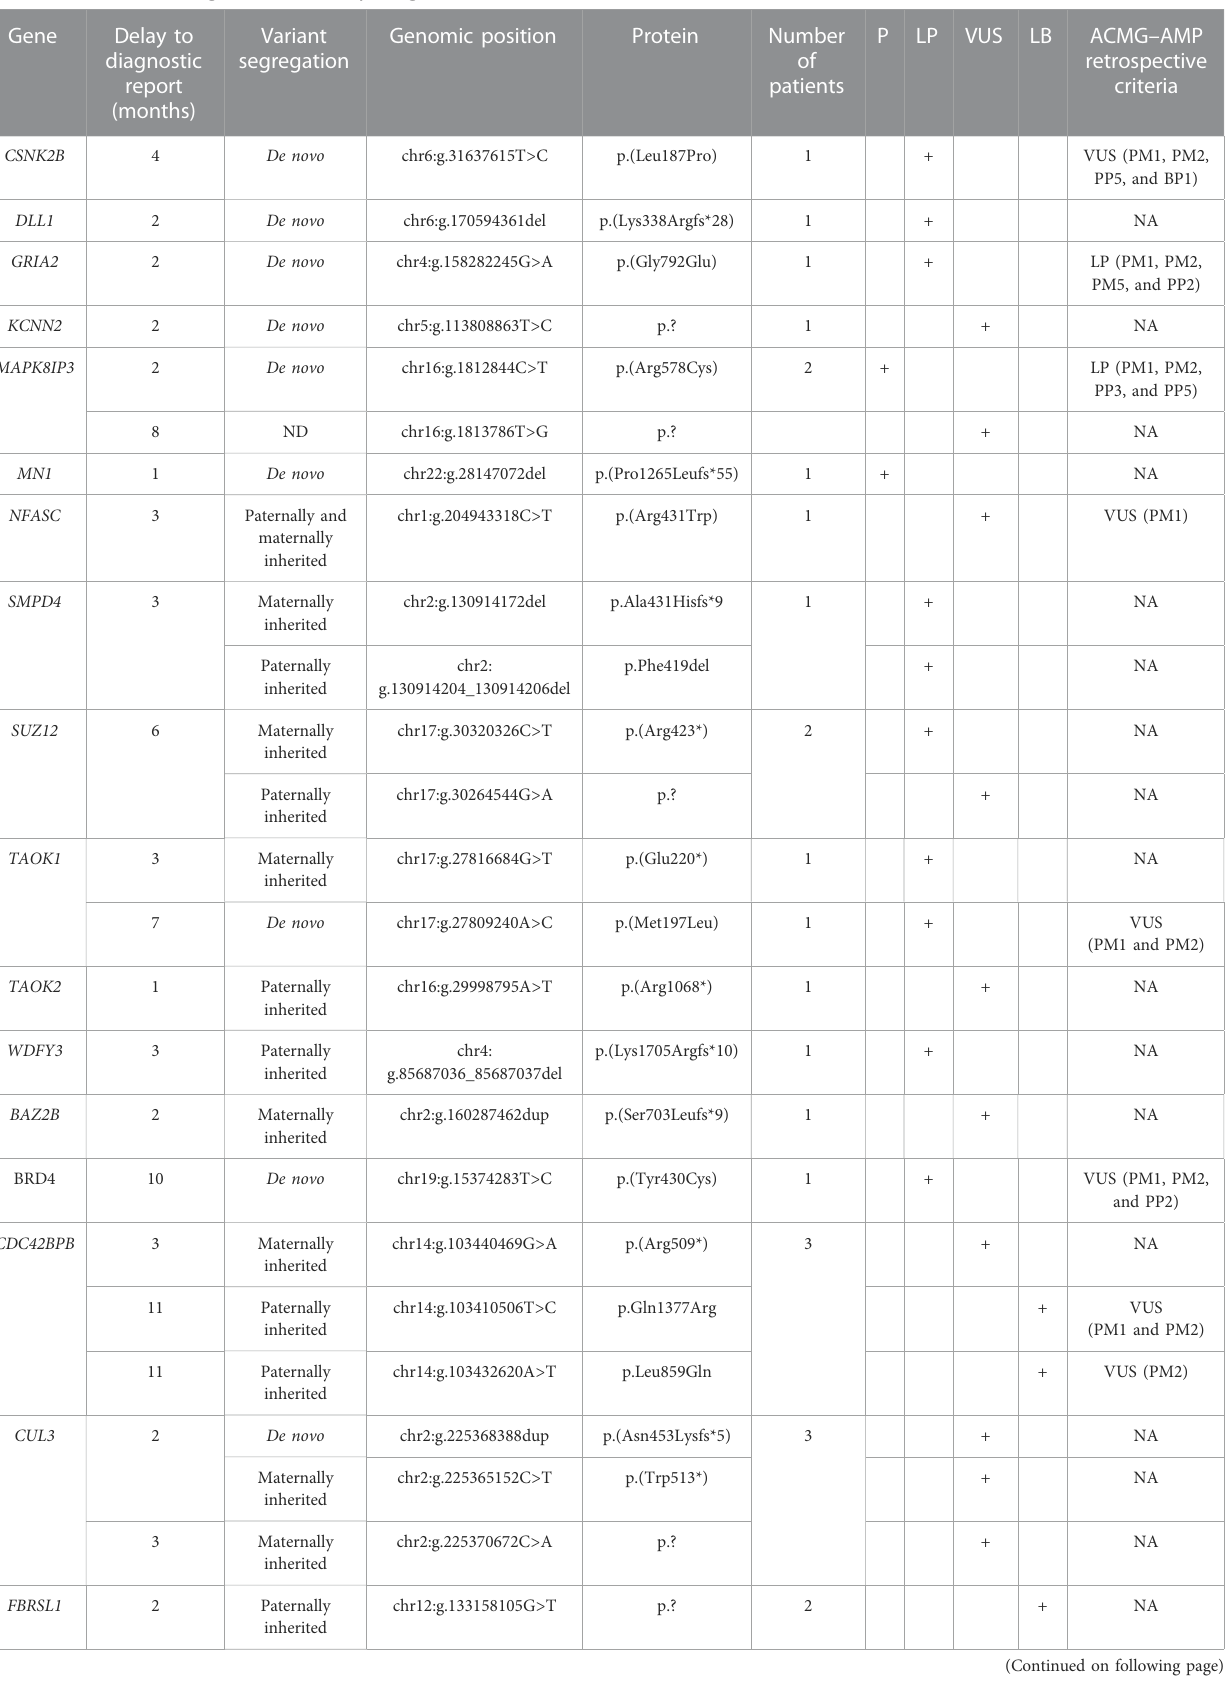
TABLE 2 Candidate variants identi fi ed using GREP queries, with classi fi cation after parental segregation. NA: not available; P/LP: pathogenic/likely pathogenic; VUS: variants of unknown signi fi cance; LB: likely benign. Gene Delay to diagnostic report (months)